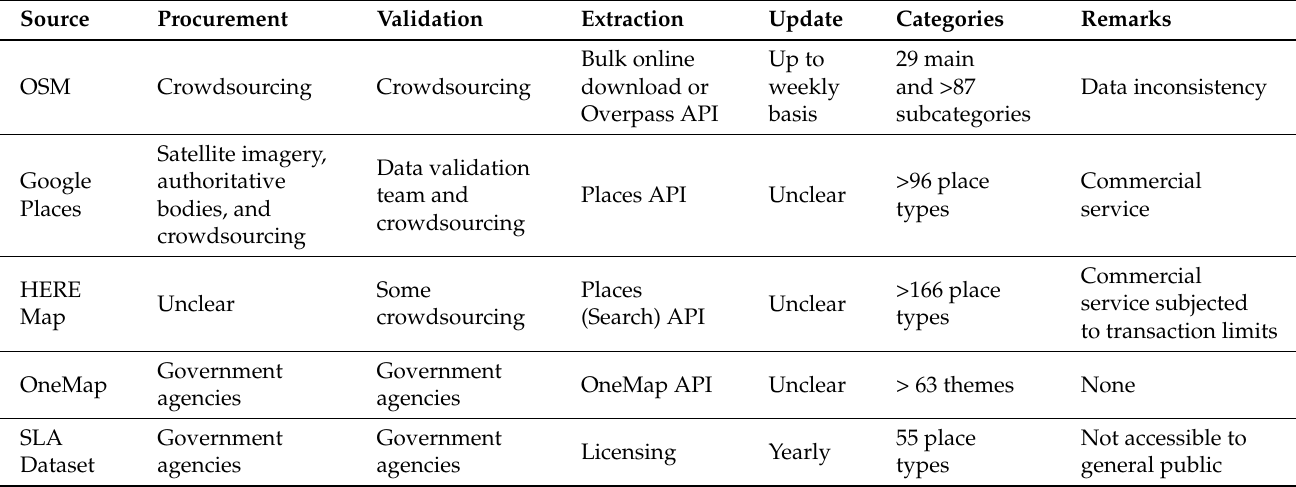
Table 2. Summary of the five POI data sources considered in this study, covering information about how their data is procured and validated, as well as their update frequencies, limitations and place type coverage